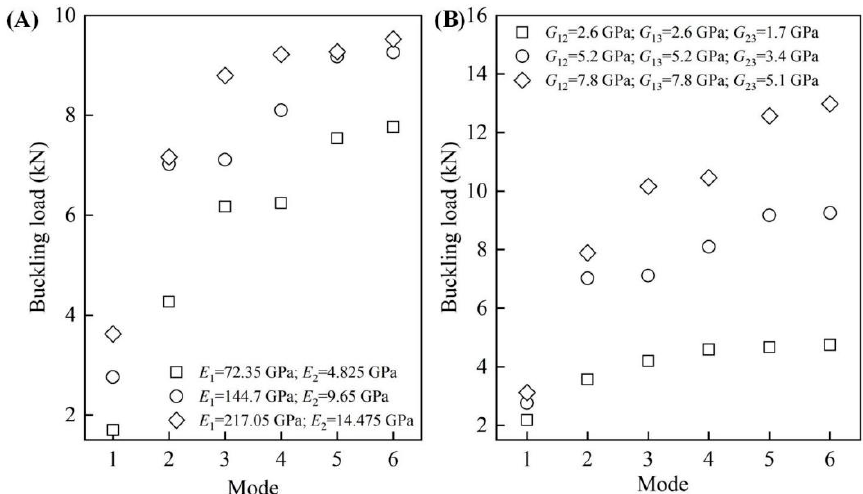
Figure 8. The influences of the material properties on the buckling loads. ( A ) Young’s modulus; ( B ) shear modulus.